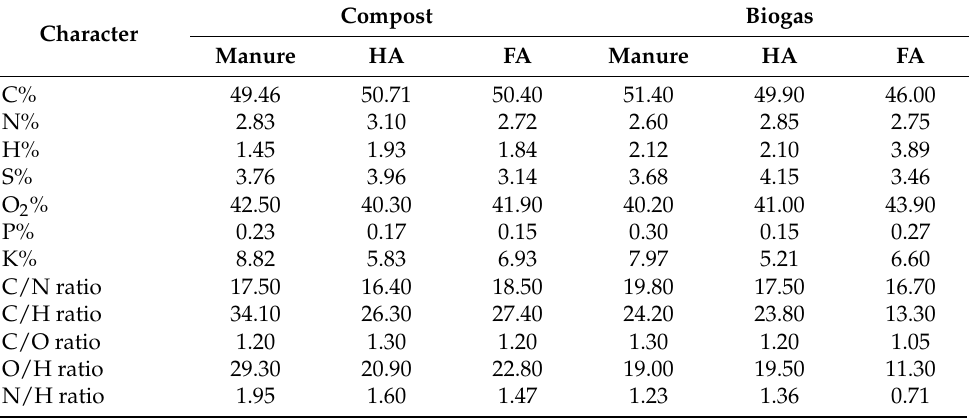
Table 2. Elemental analysis of the investigated amendments (compost manure and biogas